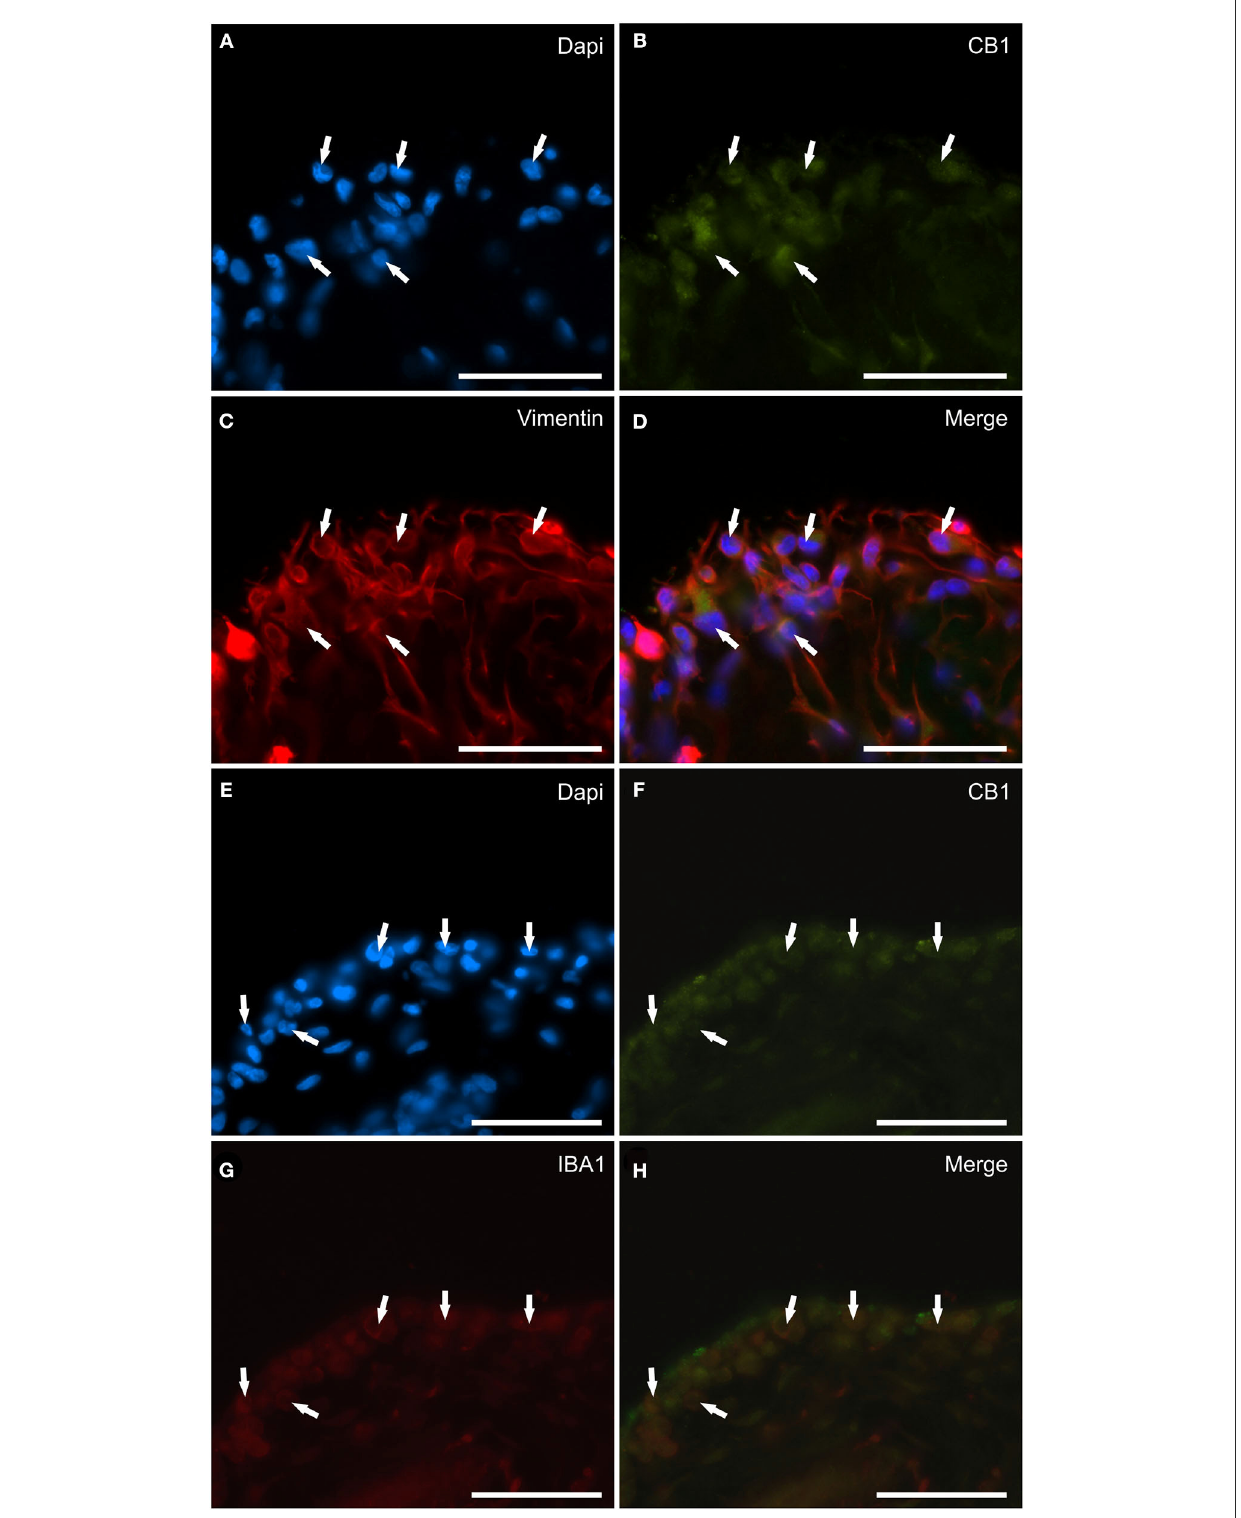
FIGURE3 Photomicrographs of the cryosections of the synovial membrane of a horse metacarpophalangeal joint showing cannabinoid receptor type 1 (CB1) immunoreactivity in synoviocytes. (A–D) The arrows indicate the DAPI (Blue) labeled nuclei (A) of cells resembling fibroblast-like synoviocytes co-expressing faint CB1 (Green) receptor immunoreactivity (B) and bright vimentin (Red) (C) immunoreactivity. (D) Merged image (Orange). (E–H) The arrows indicate the DAPI (Blue) labeled nuclei (E) of round macrophage-like synoviocytes co-expressing faint CB1 (Green) receptor (F) and IBA1 (Red) (G) immunoreactivity. (H) Merged image (Orange). Scale bar = 50 µ